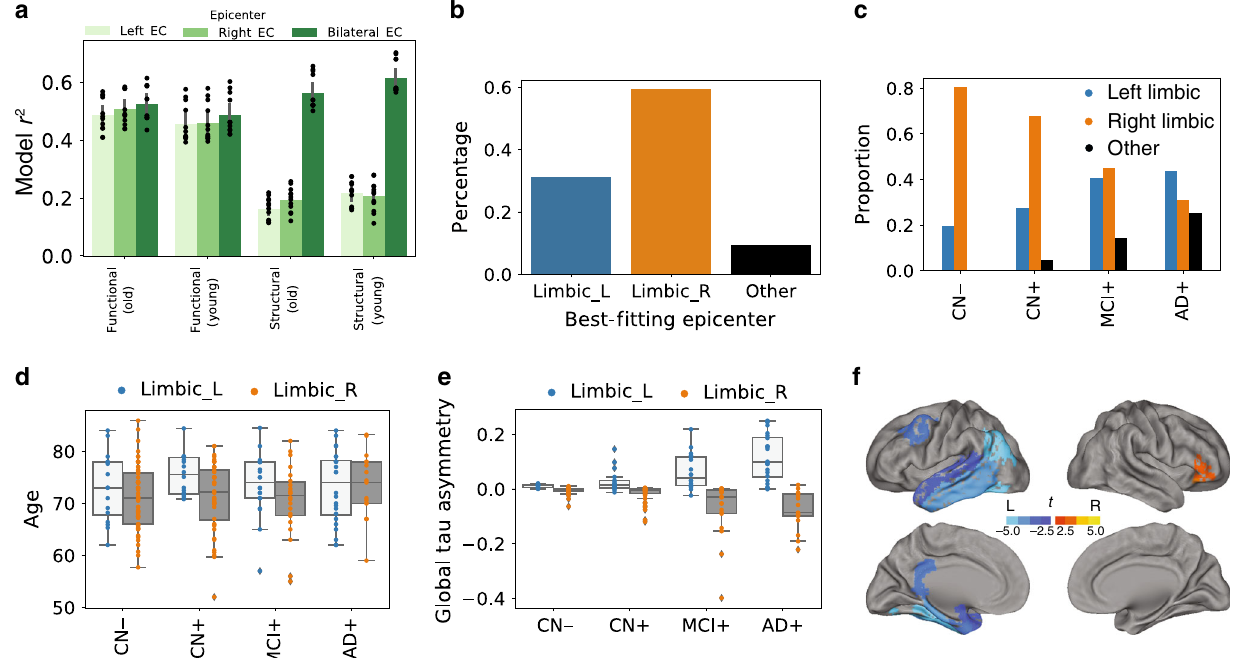
Fig. 7 Epicenter hemisphere associated with individual variation in demographics and tau-PET binding patterns. a Using only left or right entorhinal cortex alone as model epicenter did not result in improvement in model fi t. Error bars represent standard error of the mean in variation in model fi t depending on PVC strategy, confound-regression strategy, and MCI − inclusion/exclusion. b Proportion of individuals for whom a left-limbic, right-limbic, or cortical epicenter best fi t their individual tau-PET pattern. c The same, across disease progression categories. d Subjects for whom left-limbic epicenter best fi t their data were older, using a two-tailed GLM adjusting for disease status. e Epicenter hemisphere was associated with increasing hemispheric asymmetry in tau-PET signal across disease progression, using a two-tailed GLM adjusting for disease status. f Regions of higher average tau-PET signal in subjects for whom left-limbic (blue) or right-limbic (orange) epicenters best fi t their data; adjusted for age, sex, disease status, and multiple comparisons. For boxplots in panels d and e : the center line = median, box = inner quartiles, whiskers = extent of data-distribution except * = magnitude of tau in regions classically shown to harbor β - amyloid. Together, these results provides evidence that tau spreads through the limbic network in normal aging, and that the presence of β -amyloid is associated with acceleration of tau tangle expression into isocortical regions.